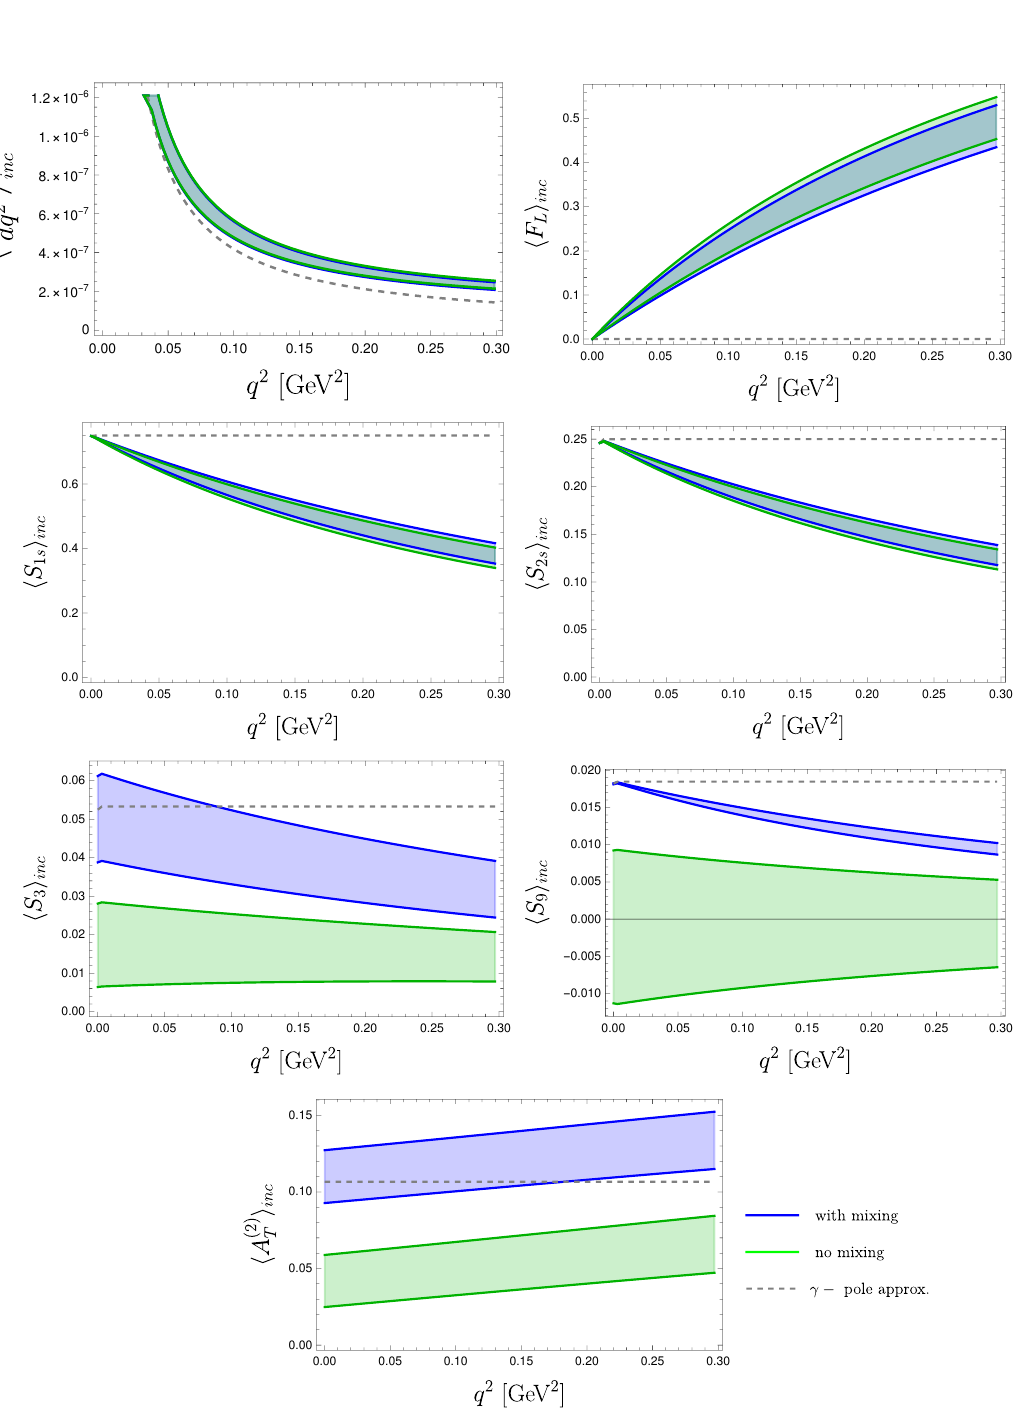
Figure 1 . SM predictions for d Br /dq 2 , and the angular observables F L , S 1 s , S 2 s , S 3 , S 9 , and A (2) as a function of q 2 . Predictions are shown for the complete expression (blue) and the photon-pole approximation (dashed gray). The full result in the absence of mixing is also shown for illustration